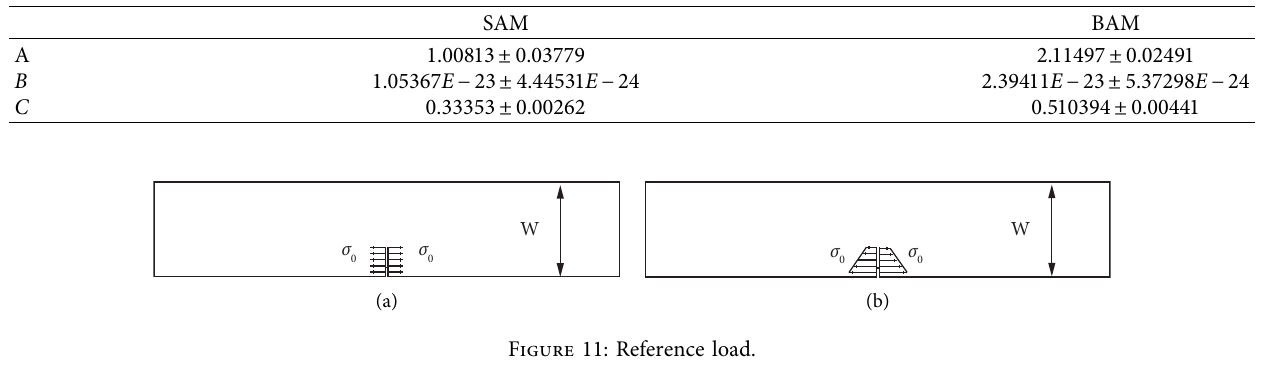
Figure 11: Reference